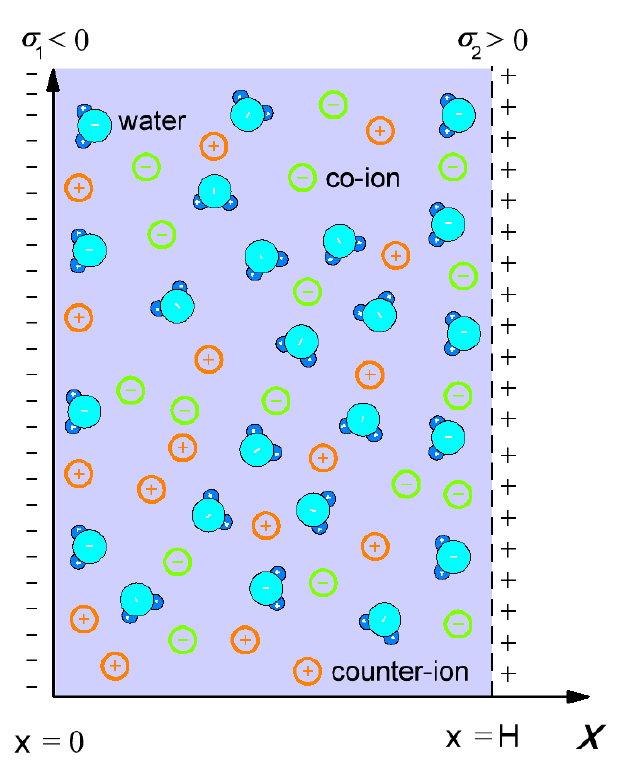
Figure 2. Schematic figure of the model of a negatively charged surface characterized by surface charge density, (cid:27) , at x = 0 and a positively charged surface with surface charge 1 density, (cid:27) , at x = H 2